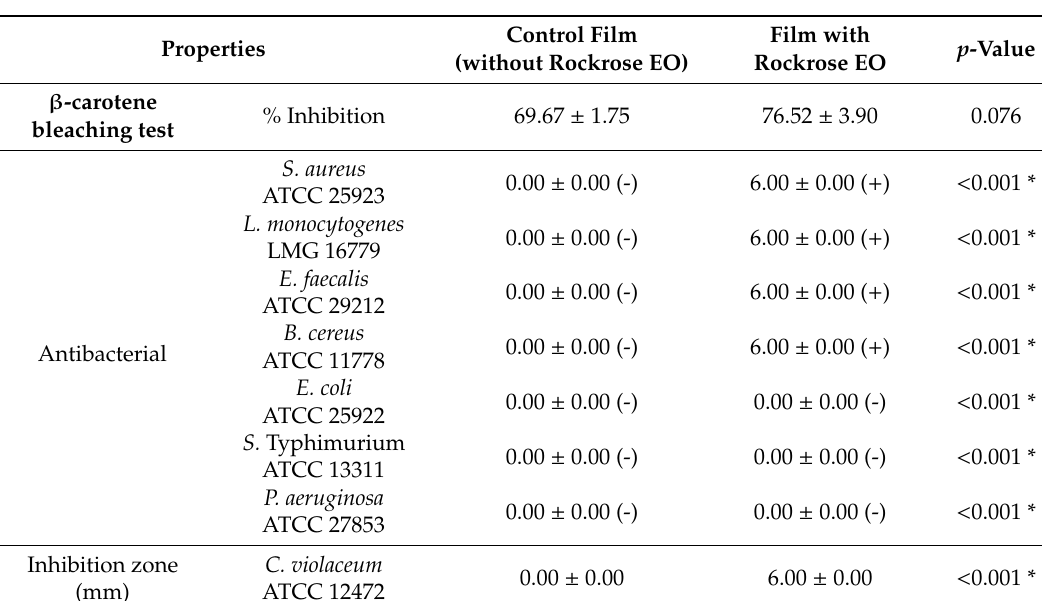
Figure 3. Antioxidant activity of the films measured by DPPH free radical scavenging assay. Table 8. Antioxidant activity ( β -carotene bleaching test), antibacterial properties and diameter of inhibition of the violacein production